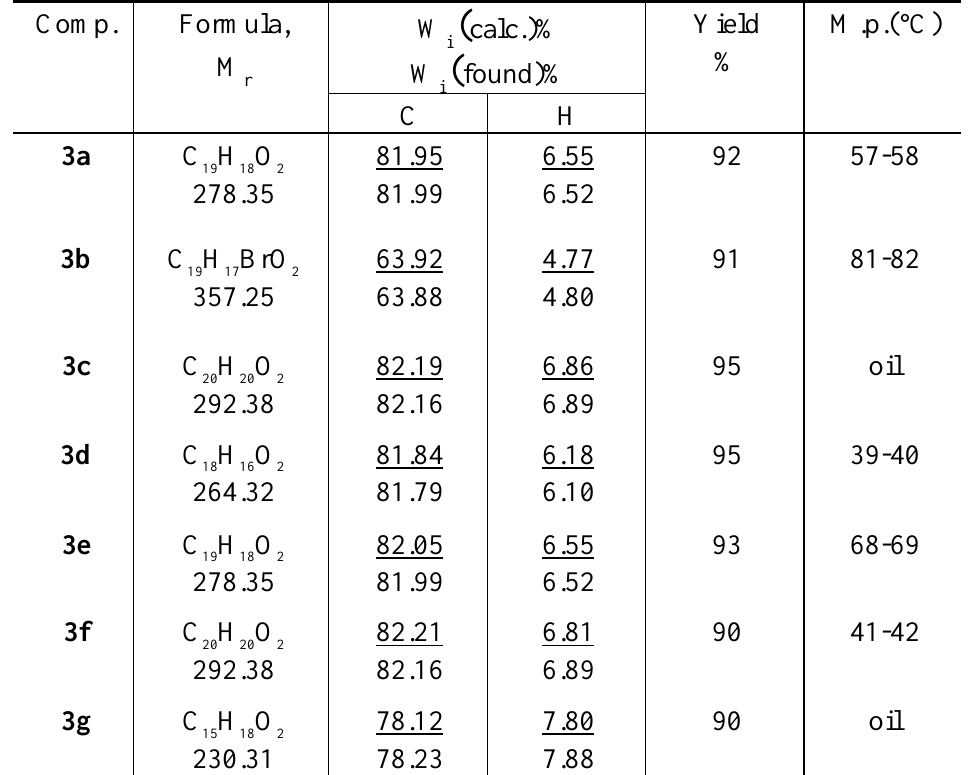
Table 3. Characterization of compounds 3a - g .